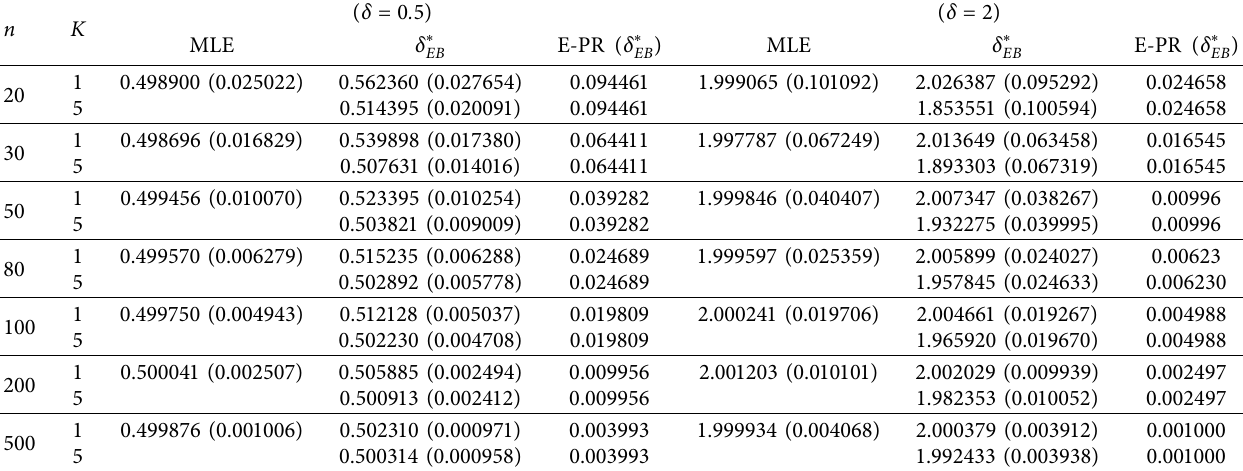
Table 7: E-B and E-PR estimates of